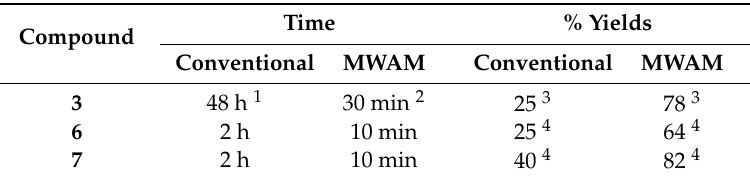
Table 1. Reaction conditions and outcomes of the conventional methods compared to the microwave-assisted methods